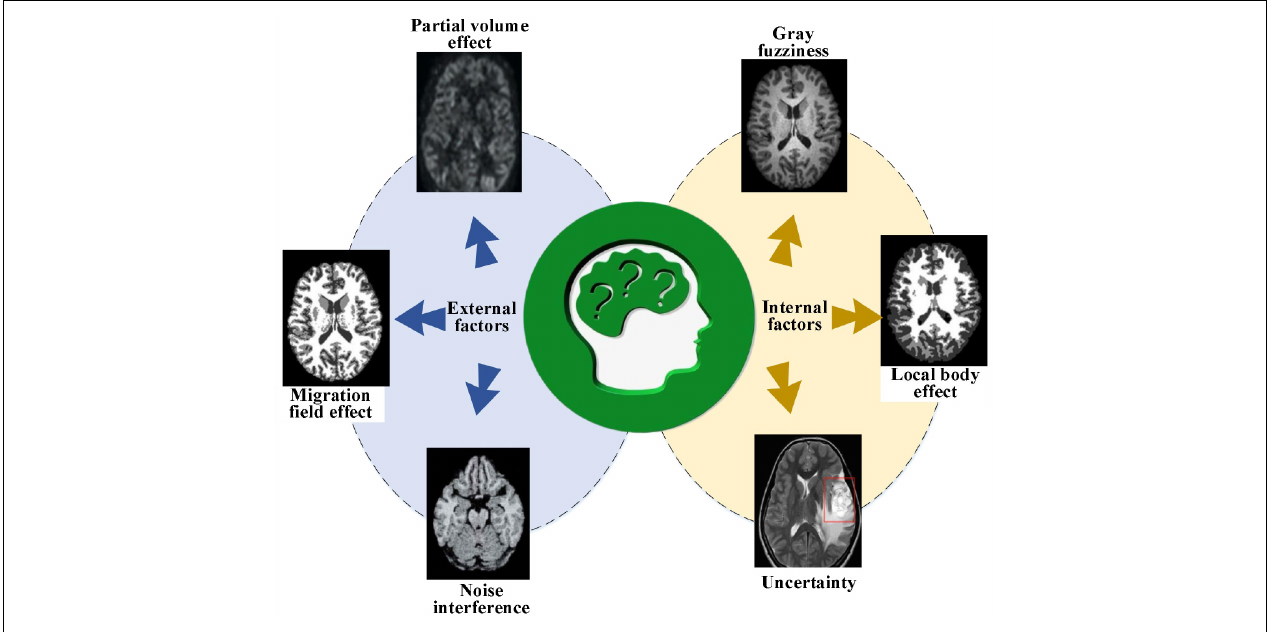
FIGURE 1 | Problems in brain medical image